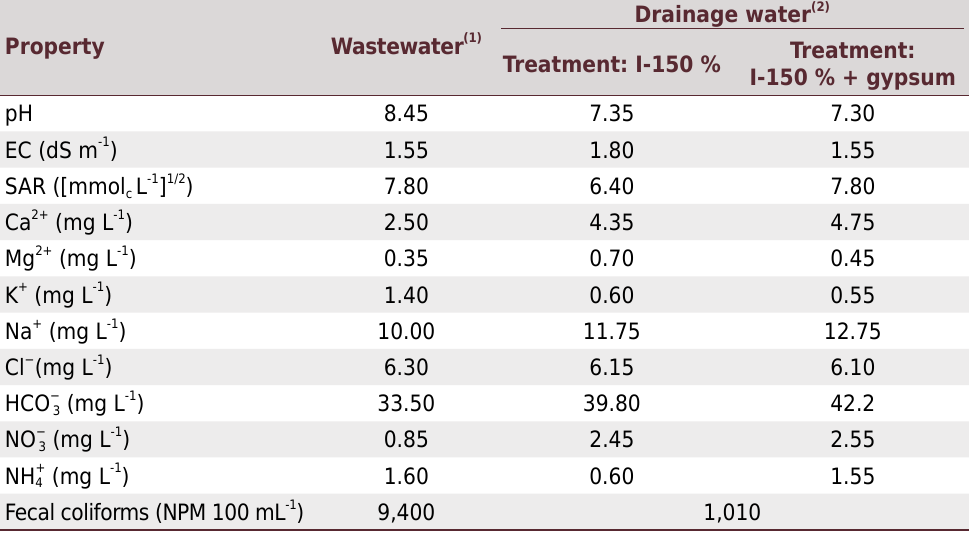
Table 1. Properties of domestic wastewater used for irrigation and of soil drainage